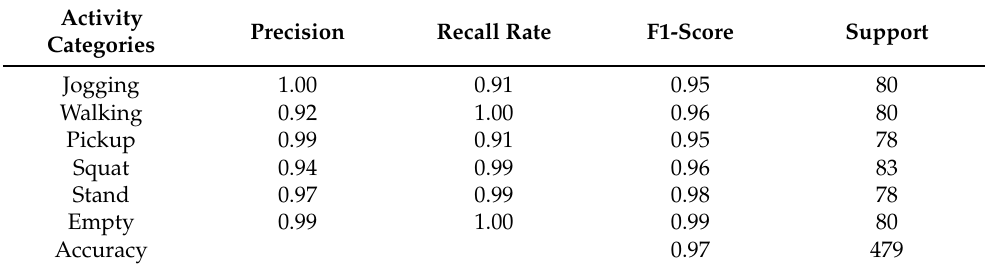
Figure 14. The main metrics of improved TPN backbone network based on amplitude and phase. Table 4. The main metrics of improved TPN backbone network based on amplitude and